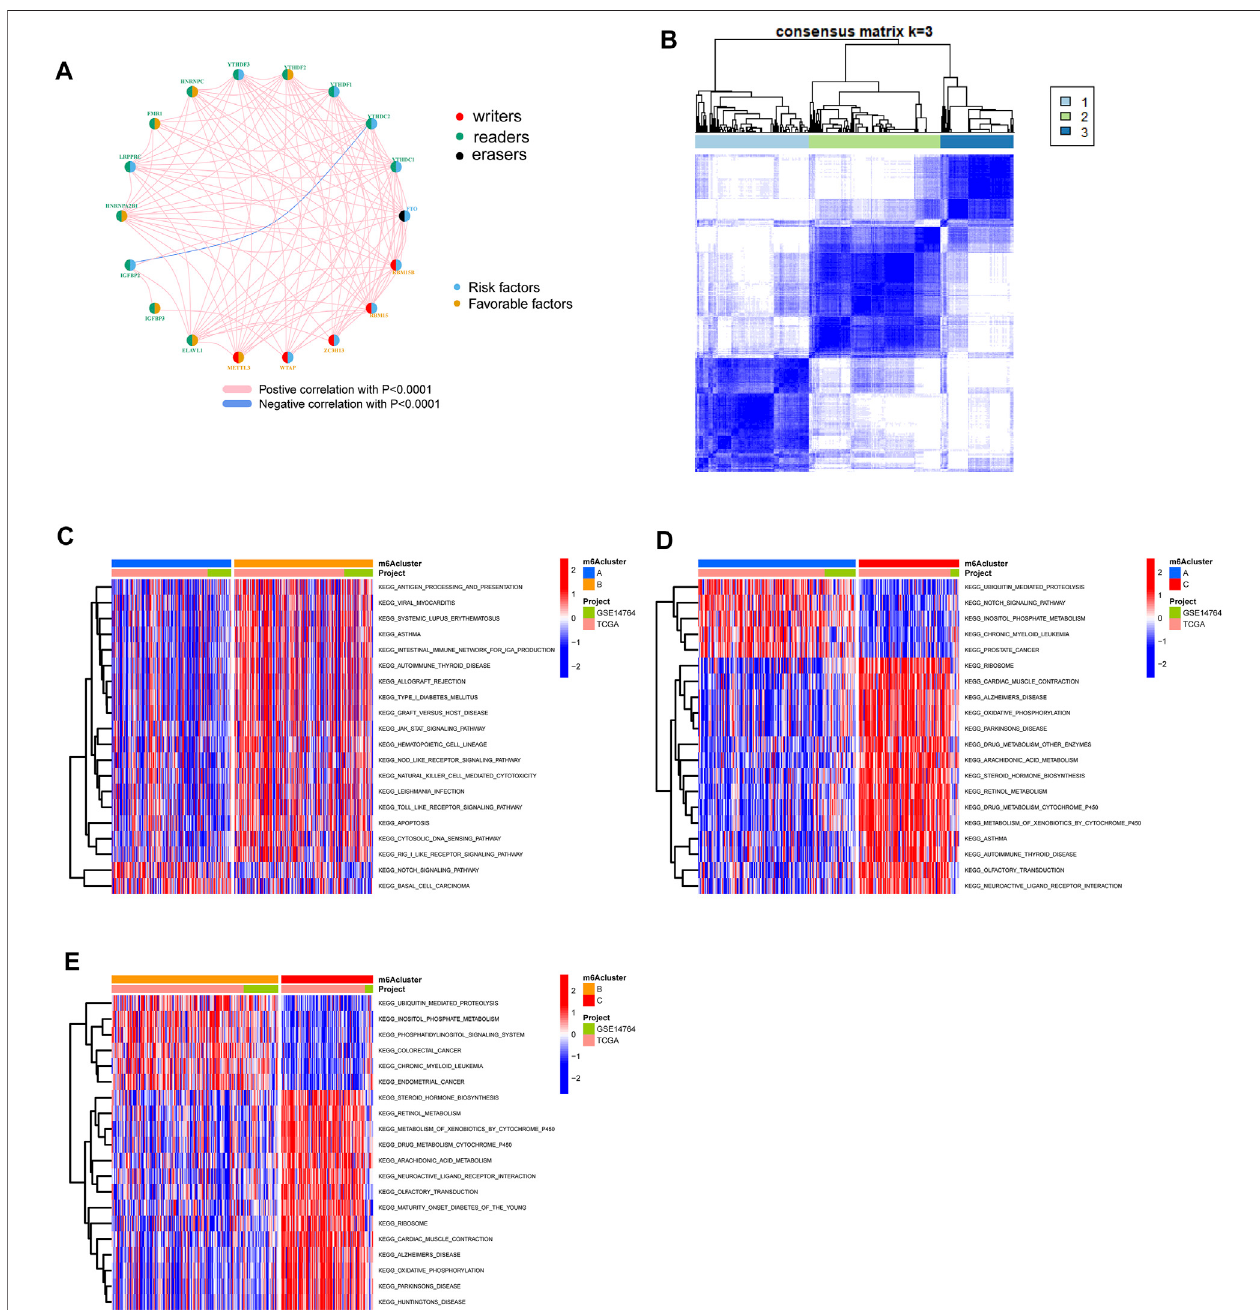
FIGURE3| Patternsofm6A methylation modi fi cation and biological characteristicsofeach pattern. (A) Theinteractionbetween m6Aregulators inovarian cancer. (B) Consensus matrices of m6A regulators according to TCGA and GSE14764 cohort for k (cid:1) 3. (C – E) . GSVA enrichment analysis showing the activation states of biological pathways in distinct m6A modi fi cation